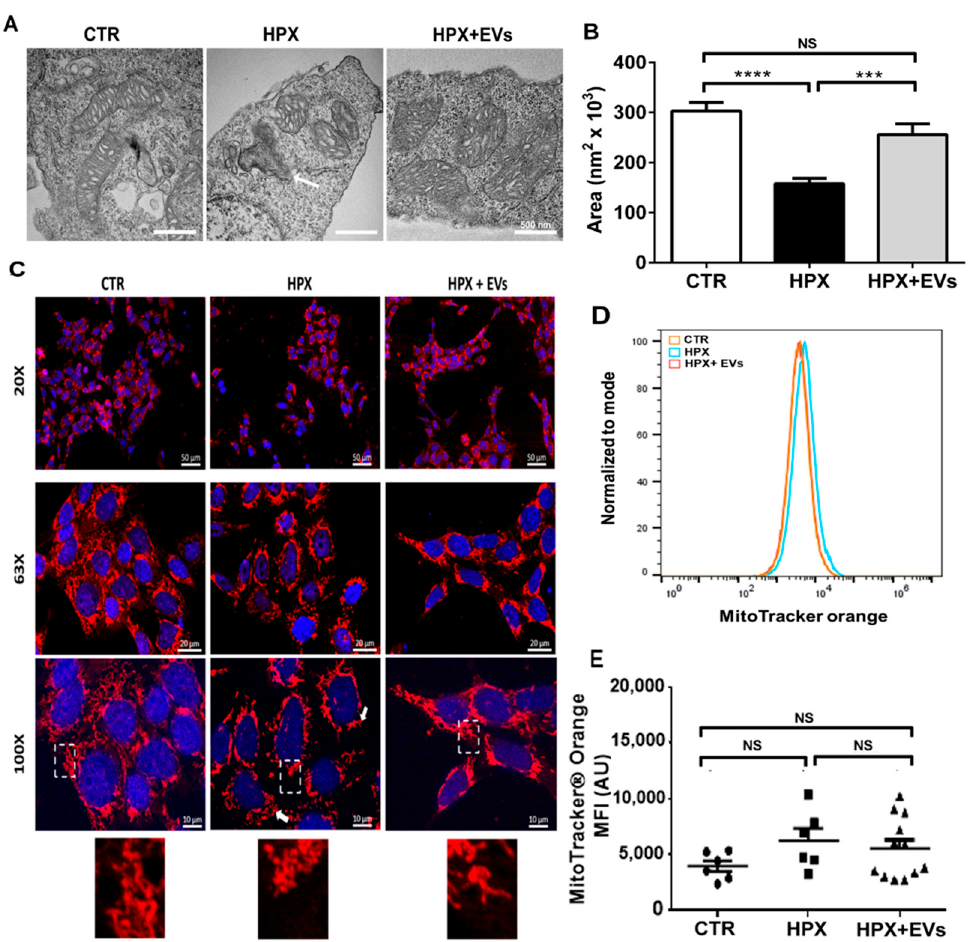
Figure 2. Evaluation of structural mitochondria damage after AKI and EVs treatment. ( A ) Trans- mission electron microscopy images of mitochondria from HK-2 cells in CTR, HPX, and HPX + EVs conditions, as indicated above the panels. Arrowhead in HPX points to a typical myelin figure. ( B ) Quantification of the mitochondrial areas. Bars represent mean ± SEM ( n = 34, 37, 30 areas for CTR, HPX, and HPX + EVs groups, respectively). ( C ) Representative fluorescence images of MitoTracker™ Orange (red areas) to evaluate mitochondrial ∆ ψ in CTR, HPX, and HPX + EVs. Nuclei are stained in blue (DAPI). Magnifications are indicated on the left side of the panels. The insets in the 100 × magnification pictures are presented just below the panels. ( D ) The percentage of events in cytometry analyses (normalized to modal value) at the arbitrary fluorescence intensity units indicated on the abscissa. The small colored squares indicate the experimental conditions: orange, CTR; blue, HPX; red, HPX + EVs. The histograms of CTR, HPX, and HPX+EVs overlap. ( E ) The mitochon- drial mean fluorescence intensities (MFI) of MitoTracker™ Orange were quantified from the groups indicated on the abscissa. Scatter plots represent determinations in which median values of fluores- cence were recorded. In ( B , E ), differences were assessed using one-way ANOVA followed by Tukey’s test. ( B , E ) *** p < 0.001; **** p < 0.0001; NS: not significant.